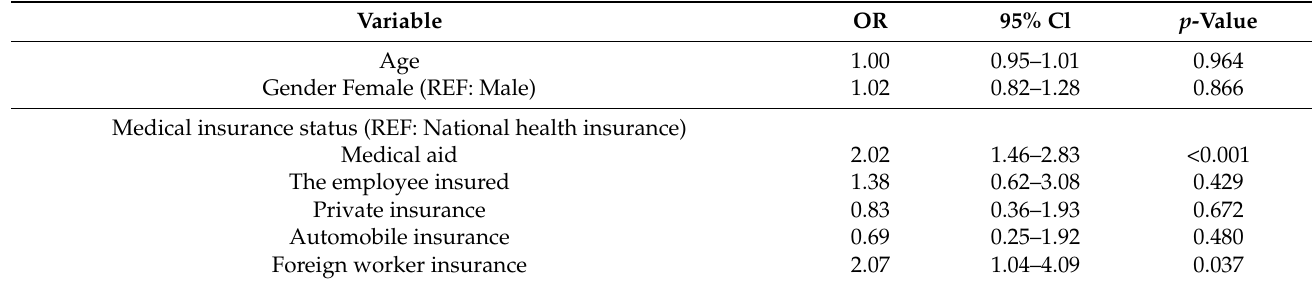
Table 4. Factors influencing readmission within 48 h after AMA